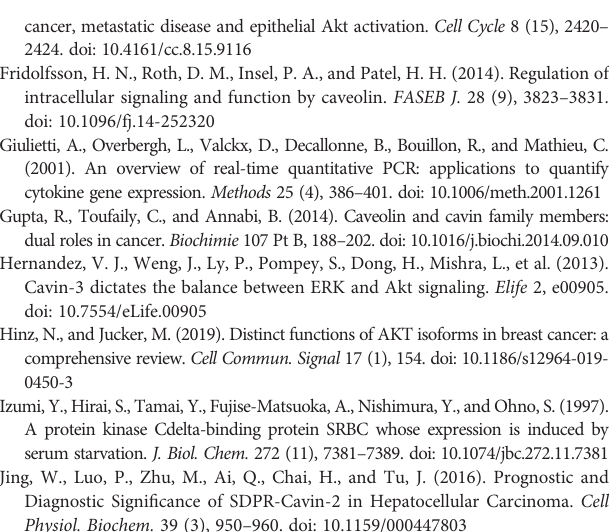
SUPPLEMENTARY FIGURE 1 | Violin plot of Cavin3 RNA expression (all RNA- seq data) according to molecular subtypes of breast cancer by bc-GenExMiner v4.4. Cavin3 RNA levels in luminal A and B subtypes are signi fi cantly lower than those in basal-like and HER2 over-expression subtypes. SUPPLEMENTARY FIGURE 2 | Impact of cavin3 protein expression on distant metastasis-free survival (DMFS) strati fi ed by tumor size and lymph node status. SUPPLEMENTARY FIGURE 3 | Cavin3 has no effect on breast cancer cells ’ proliferation by cell counting assay. KO, knockout; OE, overexpression. SUPPLEMENTARY FIGURE 4 | Cavin3 has no effect on breast cancer cells ’ viability by colony-forming assay. KO, knockout; OE, overexpression. SUPPLEMENTARY TABLE 1 | Comparison of cavin3 protein expression among differentmolecularsubtypesofbreastcancerbasedonIHC.HR:hormonereceptor, HER2: Human epidermal growth factor receptor 2. SUPPLEMENTARY TABLE 2 | Correlation between cavin3 expression and initial recurrence pattern. *including 57 patients with distant